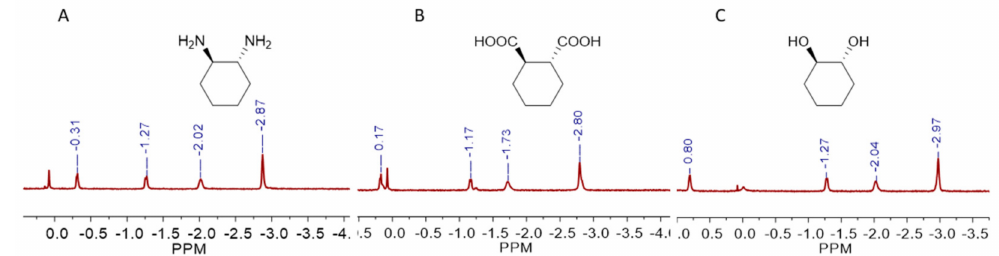
Figure 4. Partial 1 H NMR spectra of cavitand 1 upon adding from left to right ( A ): trans -1,2- diaminocyclohexane, ( B ): trans -1,2-cyclohexanedicarboxylic acid, ( C ): trans